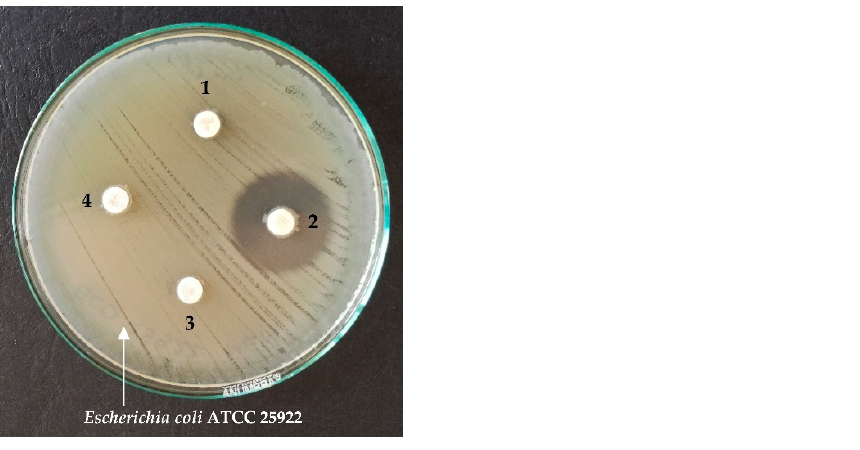
Figure 2. An example of CIM test results using meropenem discs and the reference strain E. coli ATCC 25922 for the chosen strains 1, 3, 4—positive results; 2—negative result.